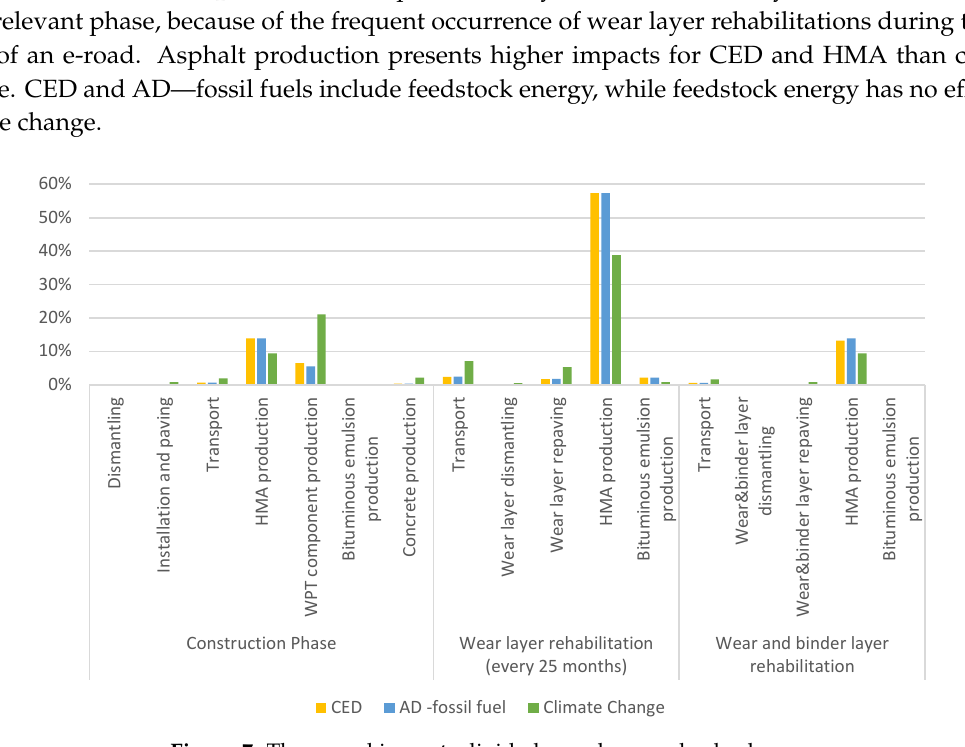
Figure 7. The e-road impacts divided per phase and sub-phase.